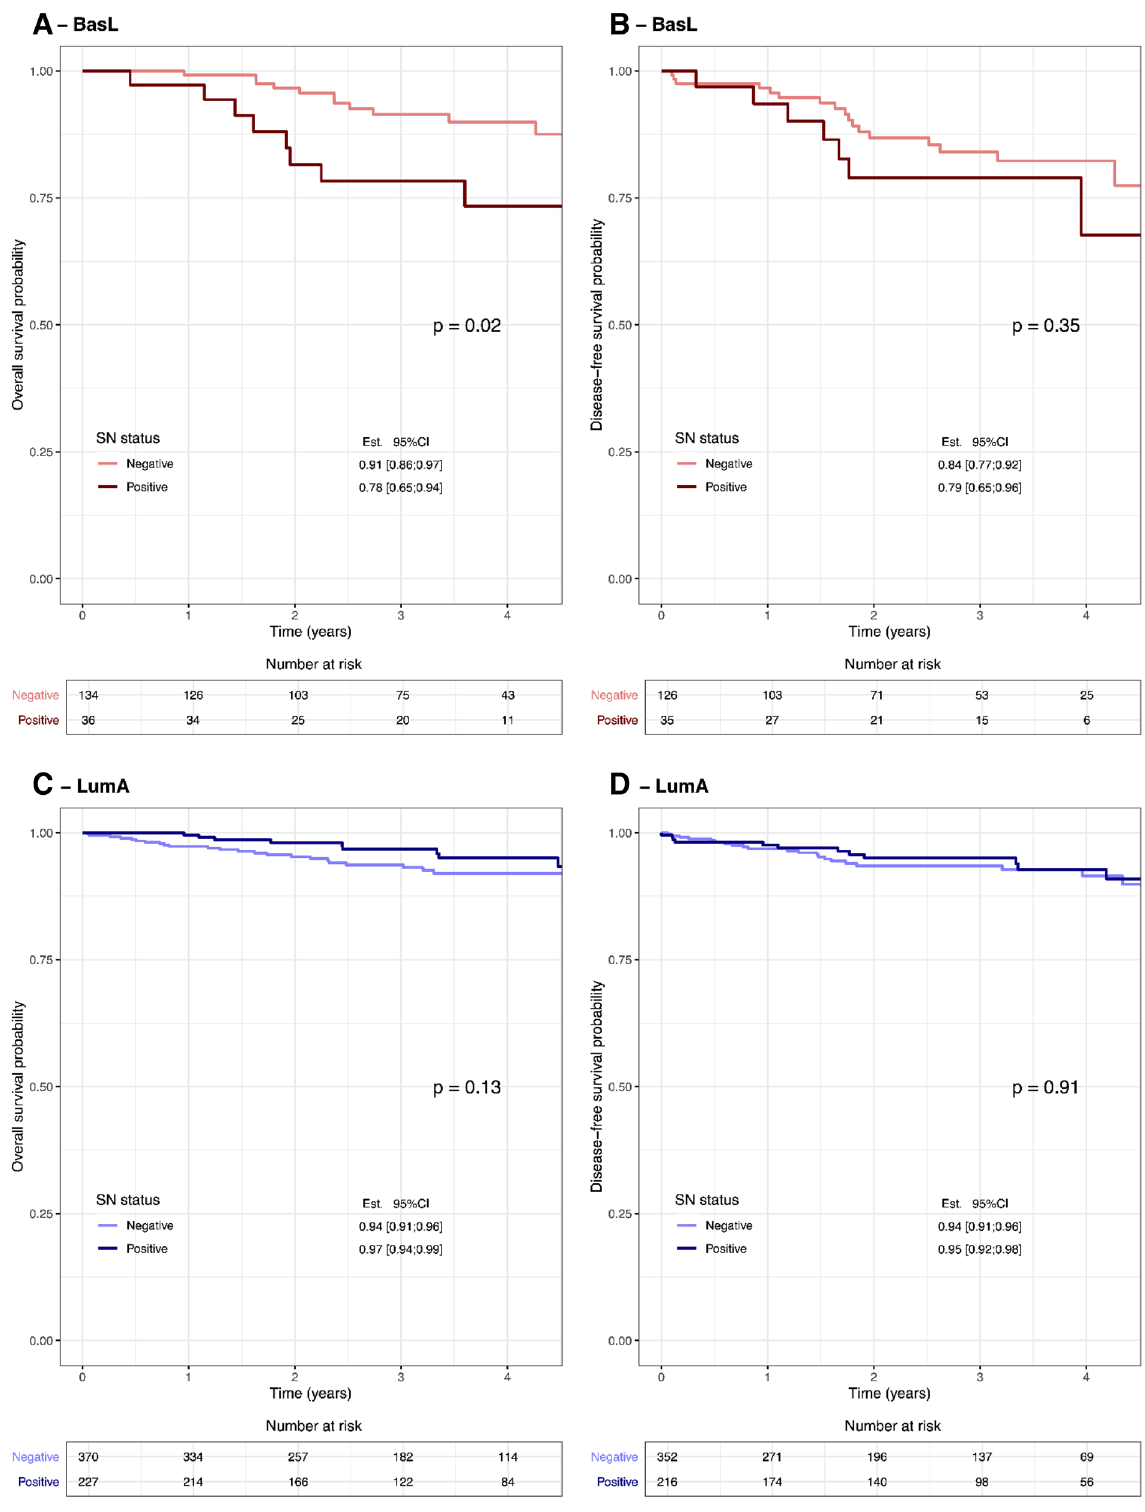
Figure 5. The overall survival of patients with a BasL subtype is depicted in ( A ). The disease-free survival of patients with a BasL subtype is depicted in ( B ). Sentinel node (SN) negative status (light pink), SN-positive status (dark red). The overall survival of patients with a LumA subtype is depicted in ( C ). The disease-free survival of patients with a LumA subtype is depicted in ( D ). SN-negative status (light blue), SN-positive status (dark blue). The estimated survival probability (Est.) and the associated 95% confidence interval (95% CI) are shown at time = 3 years for each SN status. Figure created using R 32